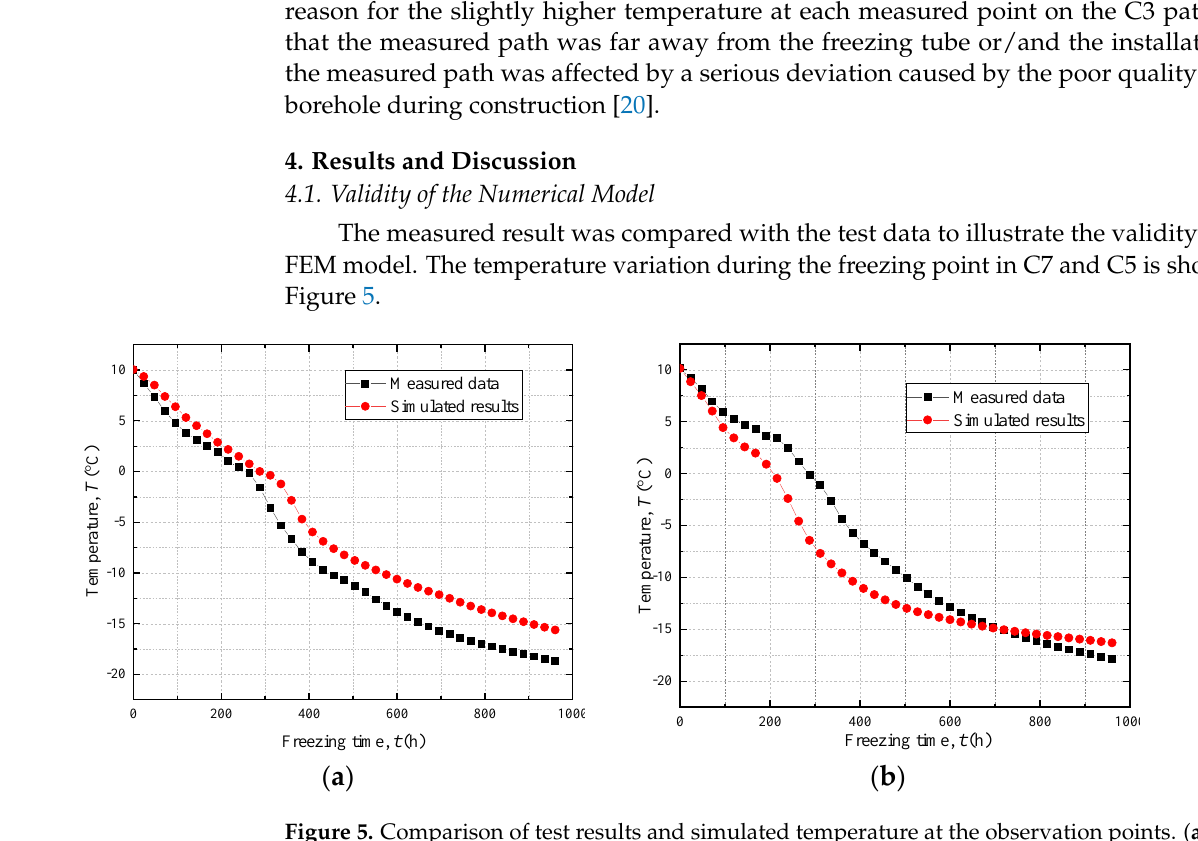
Figure 5. Comparison of test results and simulated temperature at the observation points. ( a ) Comparison on C5; ( b ) comparison on C7.